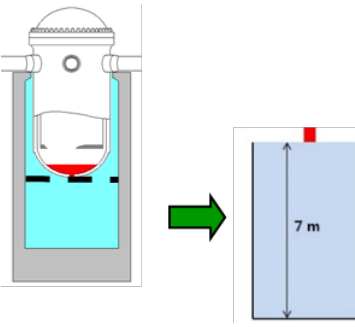
Figure 4. Schematic diagram of the IVR-ERVC state of the reactor cavity before the excore steam explosion.